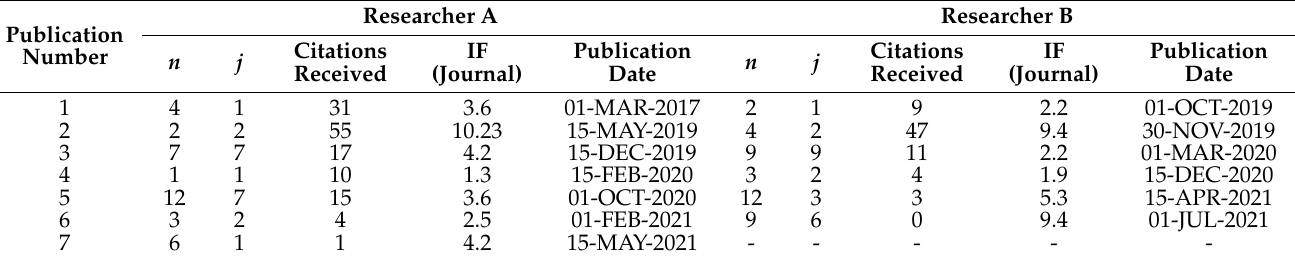
Table 5. Assumed data regarding the publications of two imaginary researchers. The current date is taken as